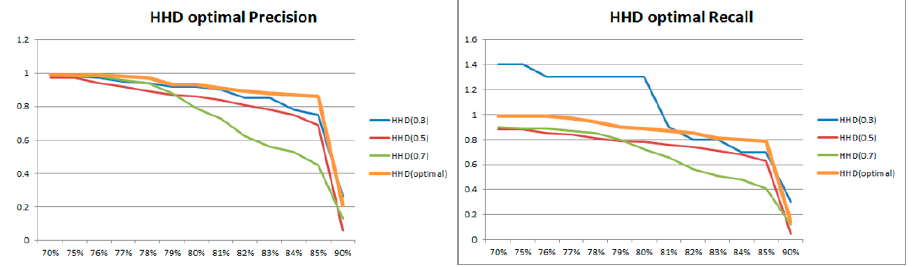
Figure 15. Precision and recall graph, by smoke concentration, with IoU = 0.3, 0.5, 0.7, and IoU optimal values, for the HHD method.